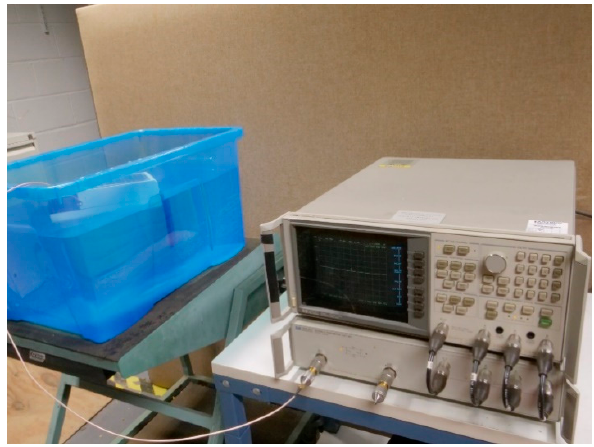
Figure 10. Experimental setup for antenna measurements.